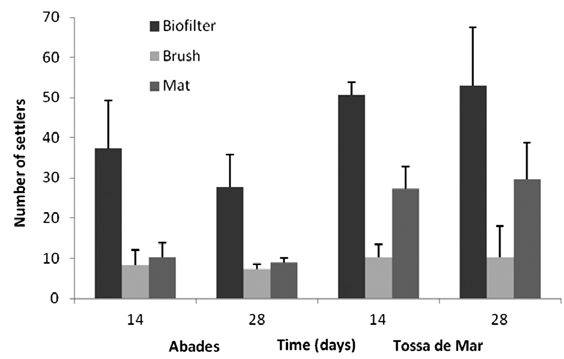
Fig. 3. – Number of Paracentrotus lividus settlers found in the arti- ficial collectors deployed at Abades and Tossa de Mar in February and June 2012, respectively. Error bars show standard